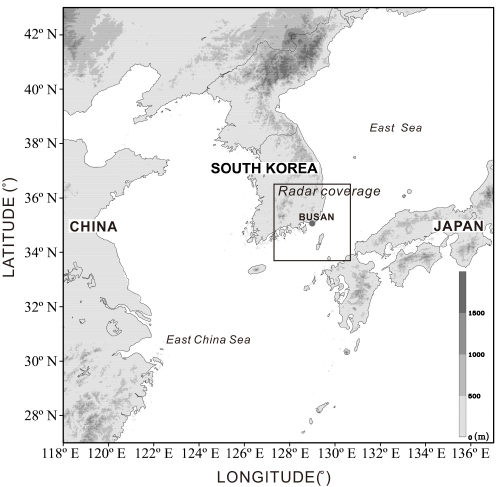
Figure 1. Geography and topography (m, shading) of South Korea and surrounding areas. The rectangle shows the region of Busan Doppler radar coverage used in this